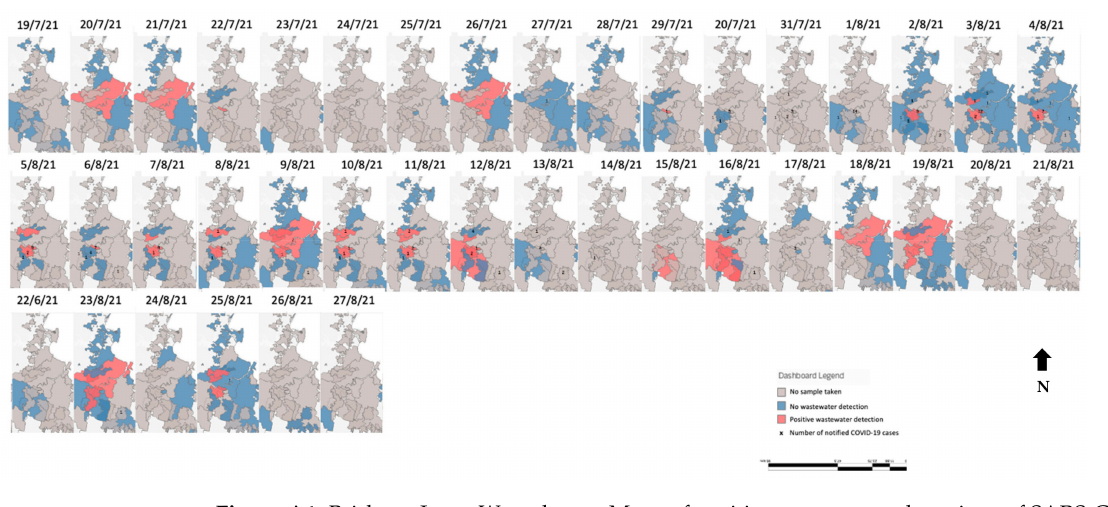
Figure A1. Brisbane Inner West cluster. Maps of positive wastewater detections of SARS-CoV-2 and positive COVID-19 case notifications—Brisbane, Queensland, 15 July–27 August 2021. The darker coloured red represents positive samples from upstream catchments when samples from the whole sewerage treatment plant catchment are also positive for SARS-CoV-2.